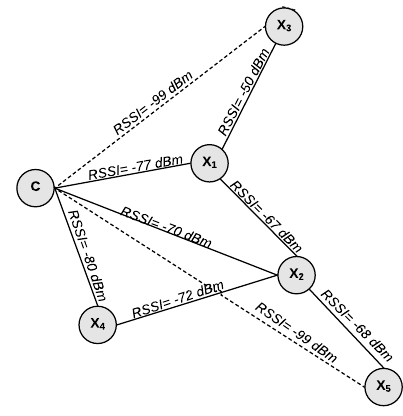
Figure 7. Network with the neighborhood of each